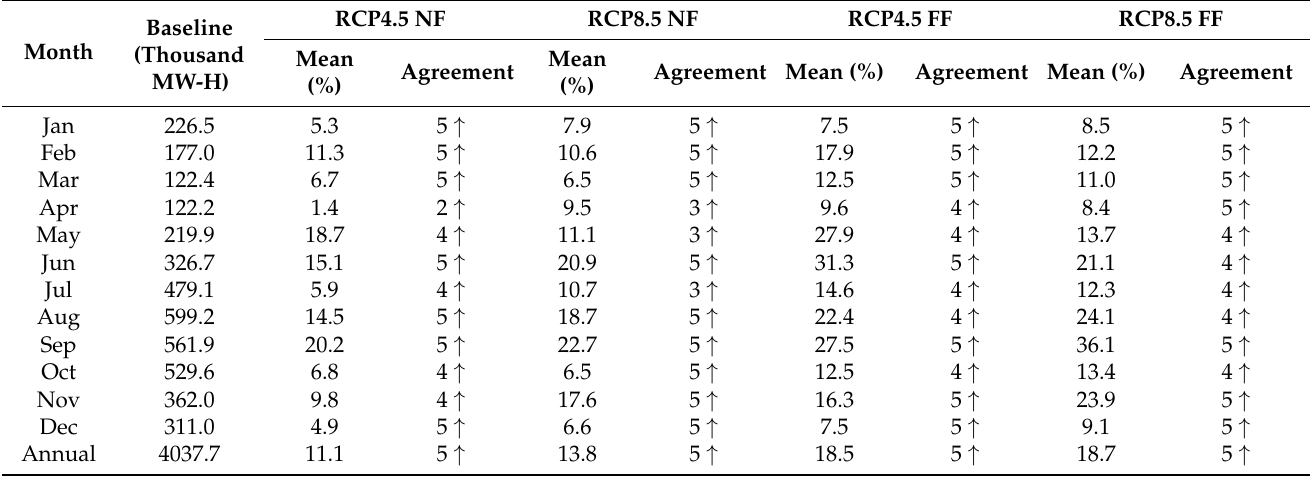
Figure 15. Potential hydropower generation in Sittaung (million MW ‐ H) from the reservoirs in Sittaung for the baseline and future under RCP4.5 (green) and RCP8.5 (red) scenarios. Table 9. Projected monthly changes in hydropower generation (in thousand MWh) under RCP4.5 and RCP8.5 emission scenarios of near and far futures and agreement among GCMs for the change. The arrows in agreement indicate the direction of change with up arrow indicating increase and down arrow indicating decrease from baseline